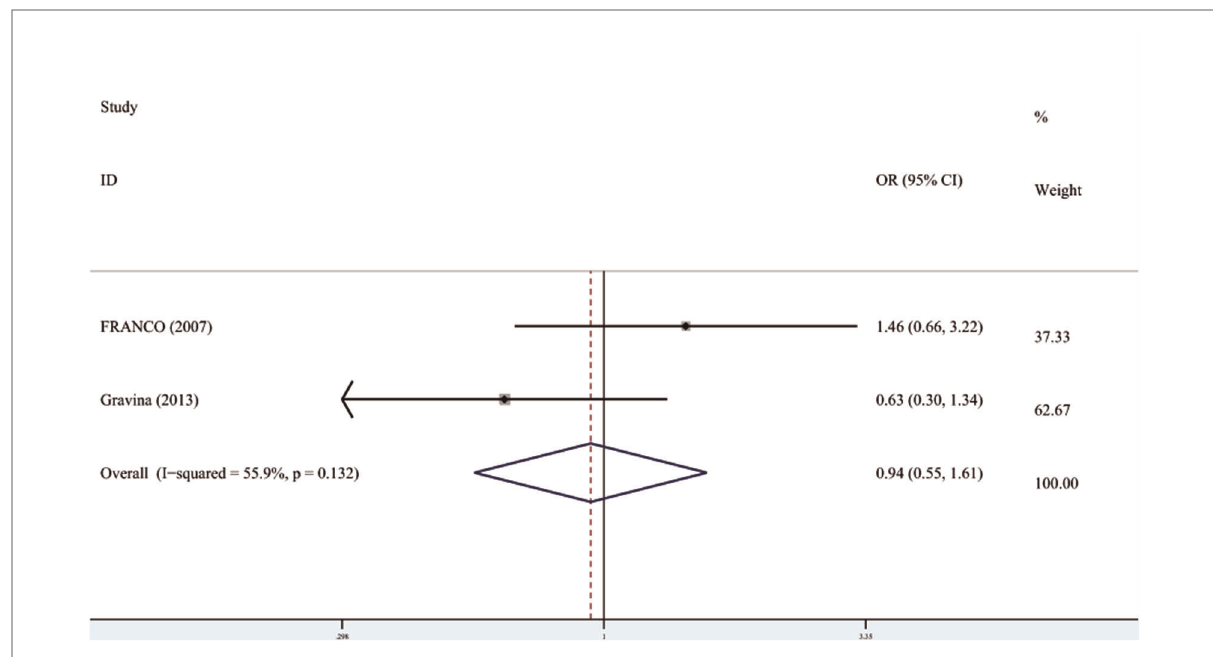
FIGURE 6 The forest plot shows the relationship between PT and enamel opacity (FEM). PT, preterm.